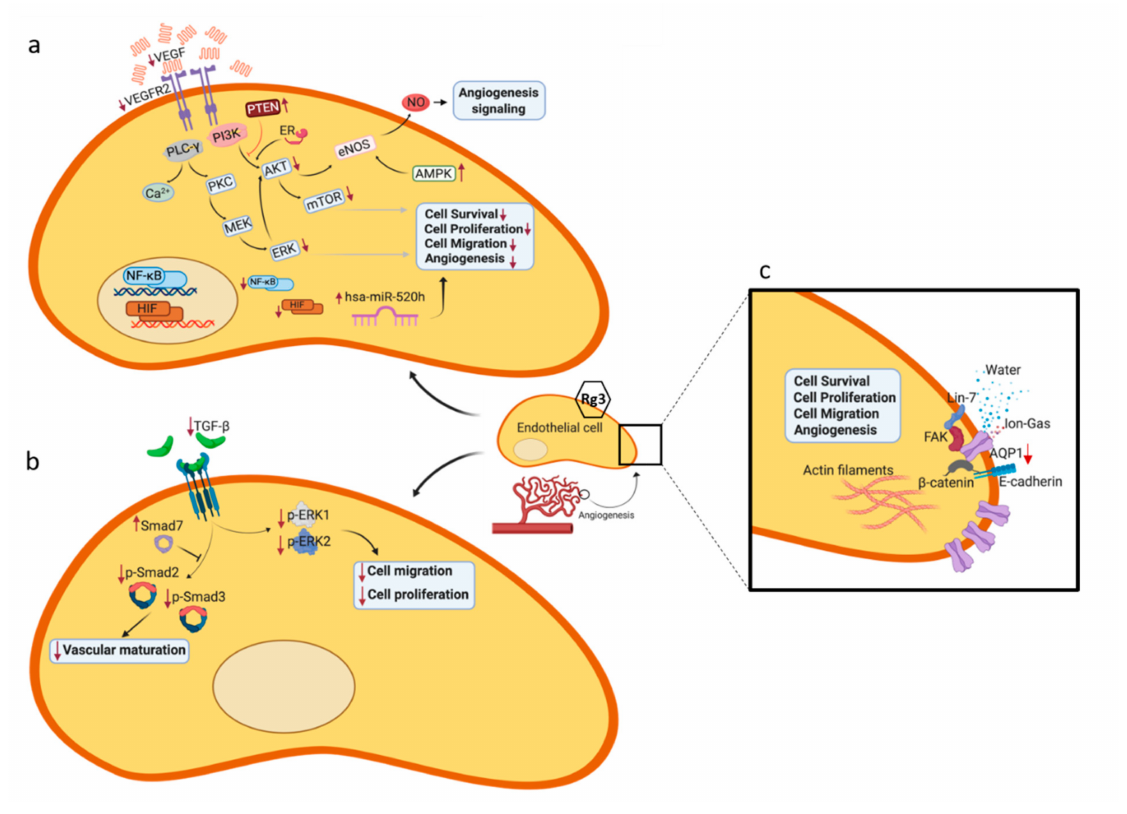
Figure 2. Signaling molecules and pathways that are a ff ected by Rg3 in an endothelial cell. ( a ) VEGF–VEGFR2 interaction and inhibition of the related signaling pathways and molecules, ( b ) decreased expression of TGF- β 1 and the related signaling molecules, ( c ) blocking the water transport function of AQP1 and decreased expression of AQP1. Red arrows ↓ and ↑ show the e ff ect of Rg3 on decreased and increased expression of molecules, respectively. Table 2. Antiangiogenic properties of Rg3 studied in di ff erent cancer